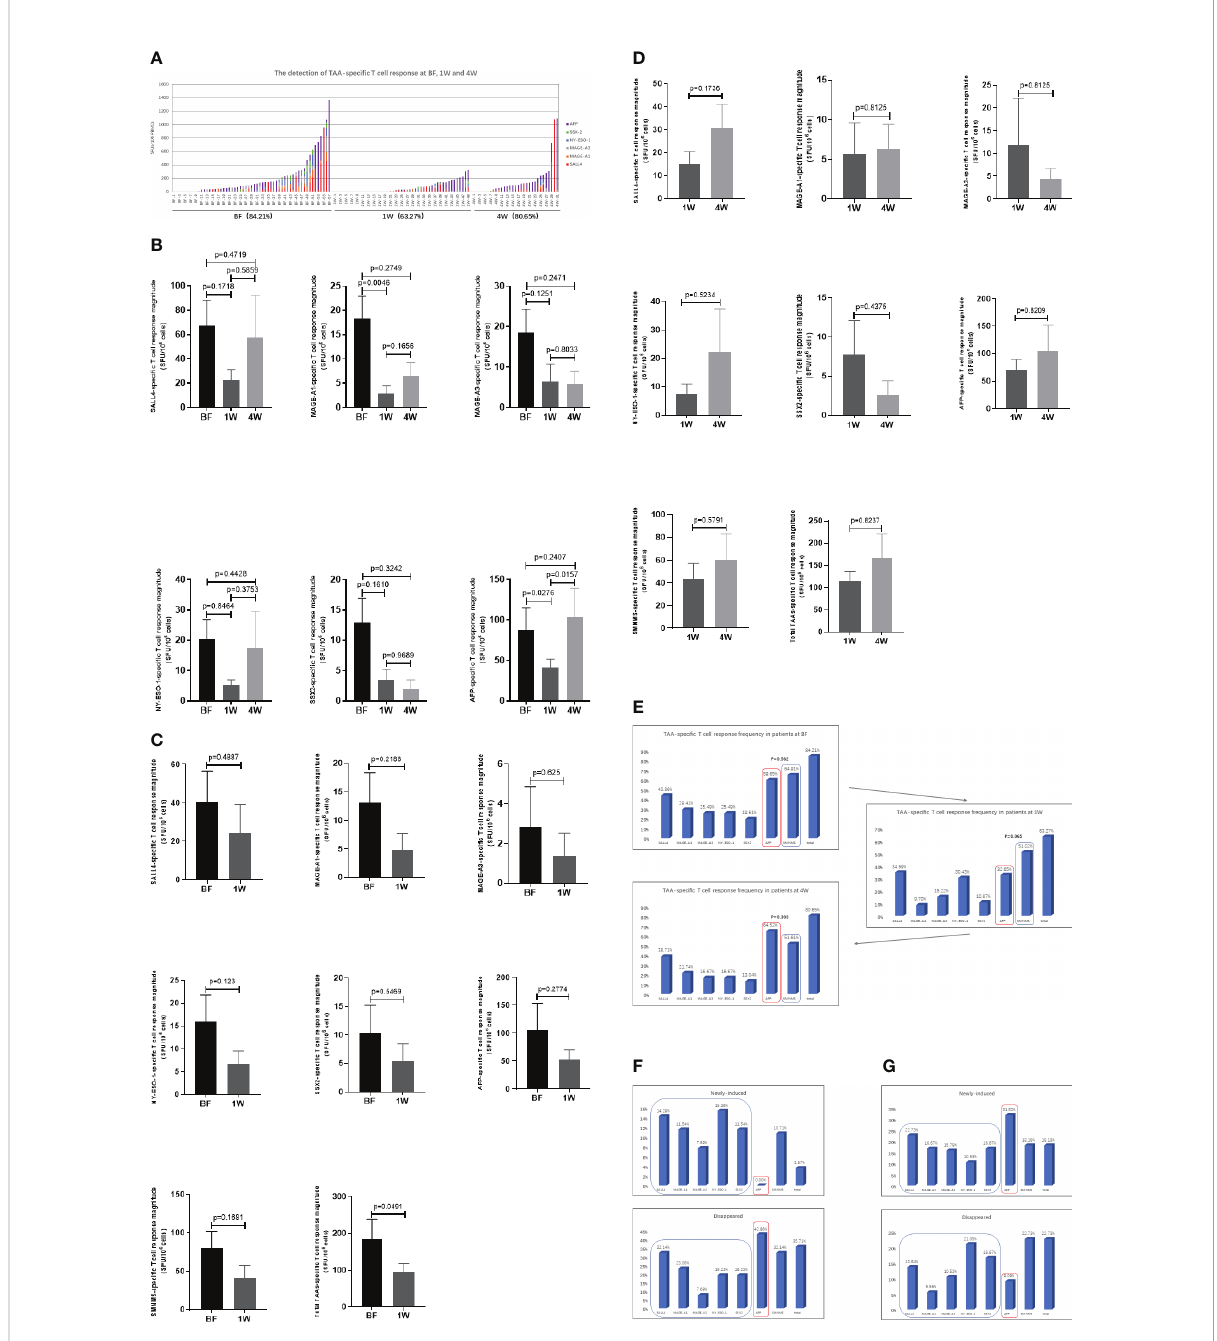
FIGURE 2 The detection of TAA-speci fi c T cell responses in HCC patients at before (BF), 1week (1W) and 4 weeks (4W) after ablation by IFN- g ELISPOT assay. (A) The distribution of TAA-speci fi c T cell responses speci fi c to AFP (purple), SALL4 (red), MAGE-A3 (grey), MAGE-A1 (orange), NY-ESO-1 (blue) and SSX2 (green) in HCC patients at BF (n=57), 1W (n=49), and 4W (n=31). The magnitude of T cell response was evaluated with SFUs/106 PBMCs in vertical coordinates (y axis), and the groups were labelled in horizontal ordinate (x axis). (B) The TAA-speci fi c T cell response magnitude was analyzed between patients at BF (n=57), 1W (n=49), and 4W (n=31). Values were compared by Mann-Whitney U-test. (C) The matching analysis of TAA-speci fi c T cell response magnitude between BF and 1W (n=28). Values were compared by paired non-parametric test. (D) The matching analysis of TAA-speci fi c T cell response magnitude between 1W and 4W (n=22). Values were compared by paired non- parametric test. (E) The TAA-speci fi c T cell immune response frequency and the appearance of the immune pro fi le at BF (n=57), 1W (n=49), and 4W (n=31). Values were compared by chi-squared test. (F) The alteration (newly-induced and disappeared) of TAA-speci fi c T cell immune response frequency and the appearance of the immune pro fi le from BF to 1W (n=28). (G) The alteration (newly-induced and disappeared) of TAA-speci fi c T cell immune response frequency and the appearance of the immune pro fi le from 1W to 4W